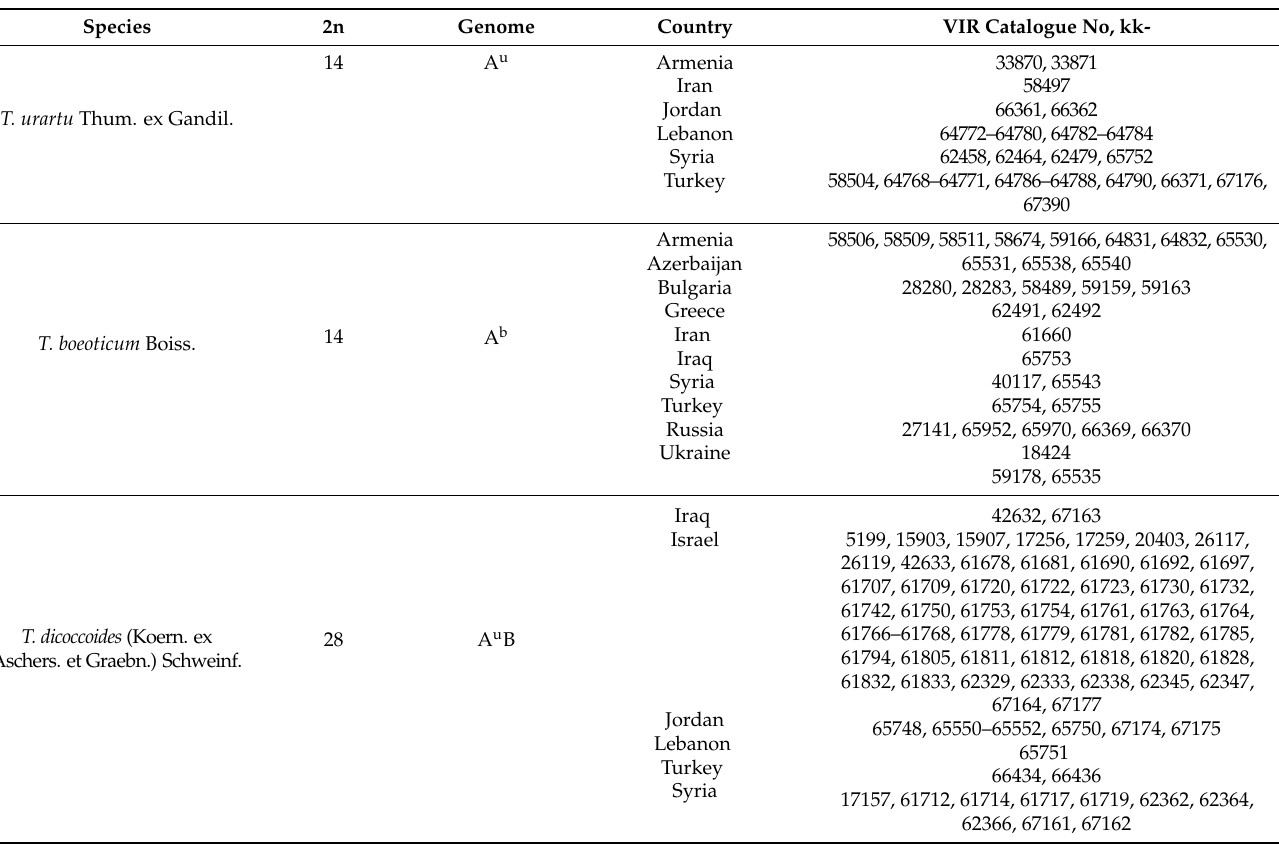
Table 1. Characteristics of wild wheat species samples studied for resistance to the diseases. 2n